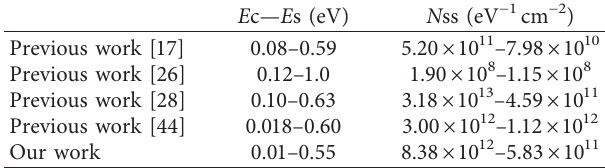
Figure 9: Distribution of interface states ( N and C-V measurements. Table 2: Extracted interface state densities and the previous